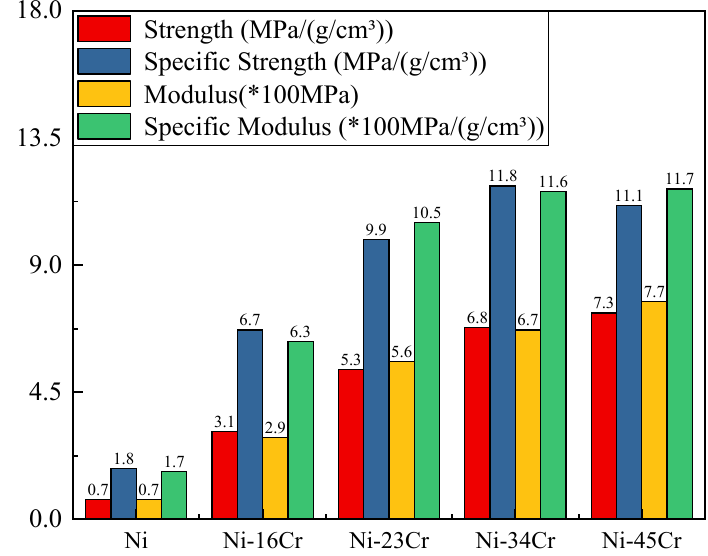
Figure 8. Mechanical properties of different NiCr alloys.